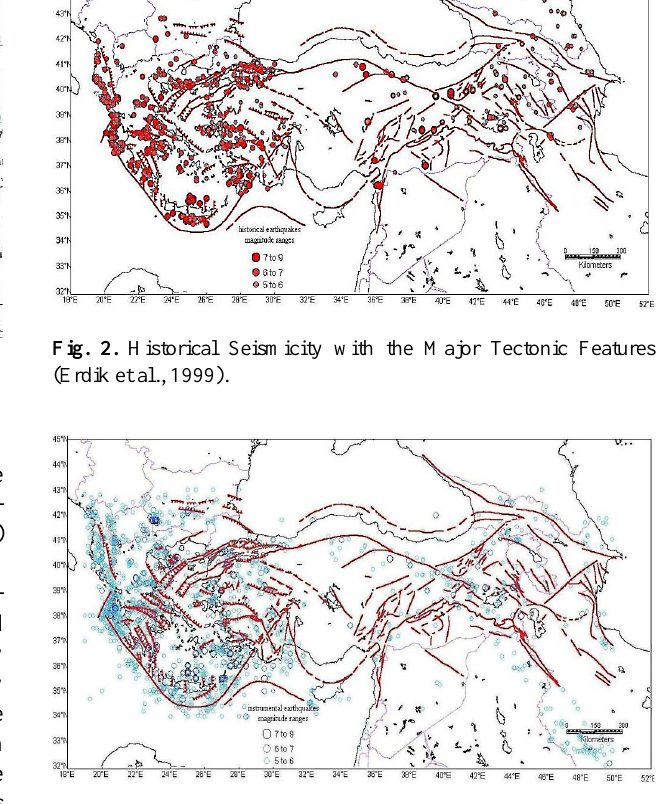
Fig. 3. Instrumental Seismicity with the Major Tectonic Features (Erdik et al.,